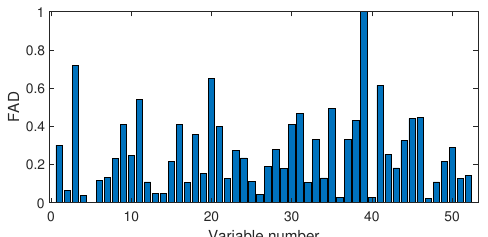
Figure 16. Fault isolation results for fault F19 based on Pearson